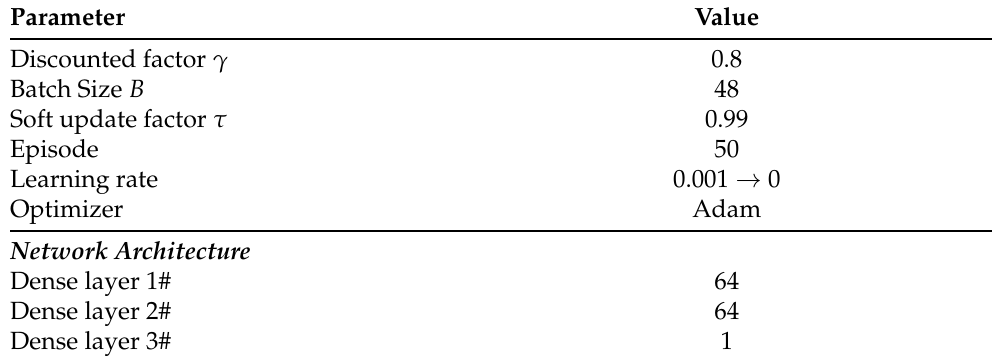
Table 2. Parameters for Neural